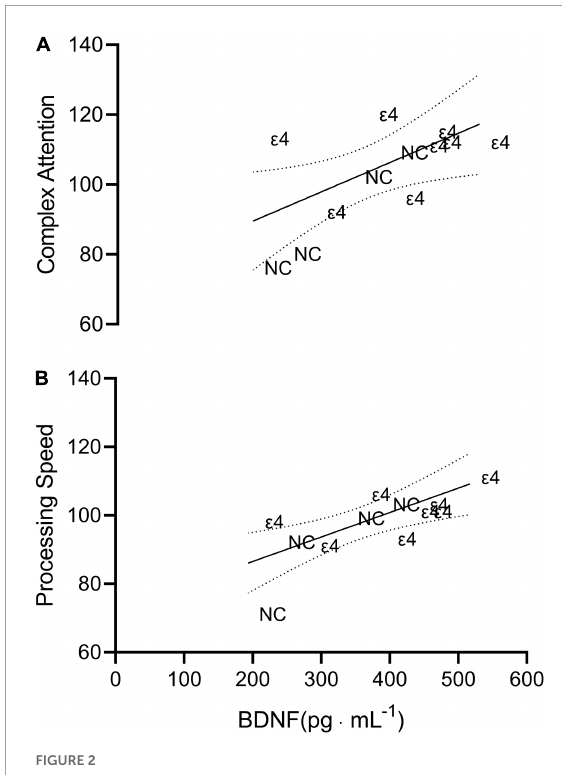
FIGURE3 Scatterplot depicting the line of best fit plus 95% confidence interval bands for peak hyperemia ( A ; r = 0.758) and processing speed ( B ; r = 0.855) vs. lean mass. Each individual data point is presented as either ε 4 or NC indicating which data correspond to individuals with apolipoprotein ε 4 carriage and non-carriers,